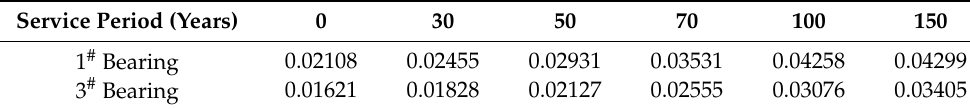
Table 5. Exceeding probability of bearing.